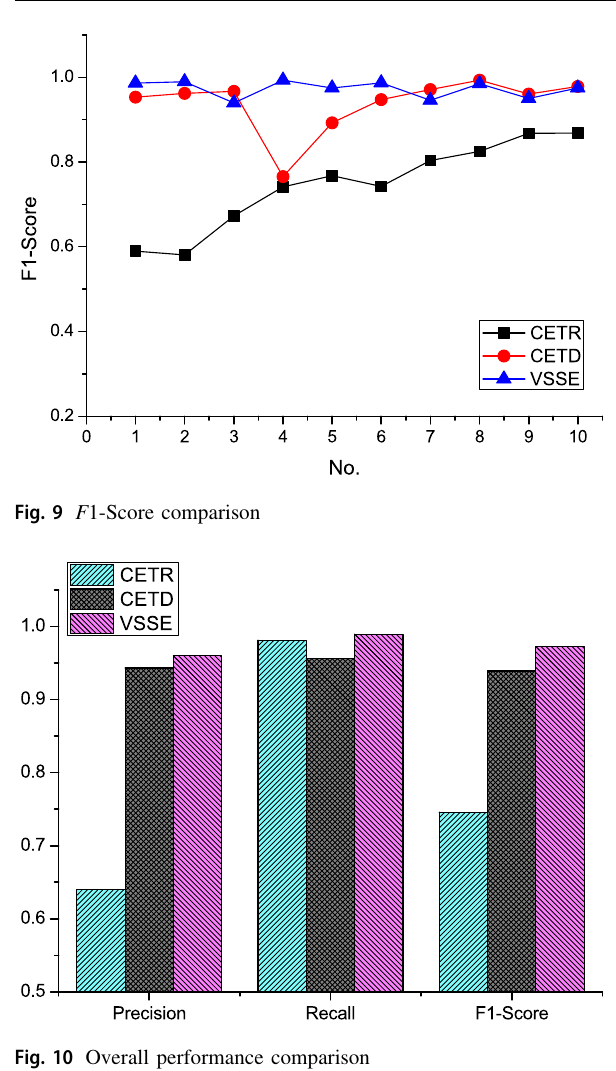
Fig. 10 Overall performance comparison